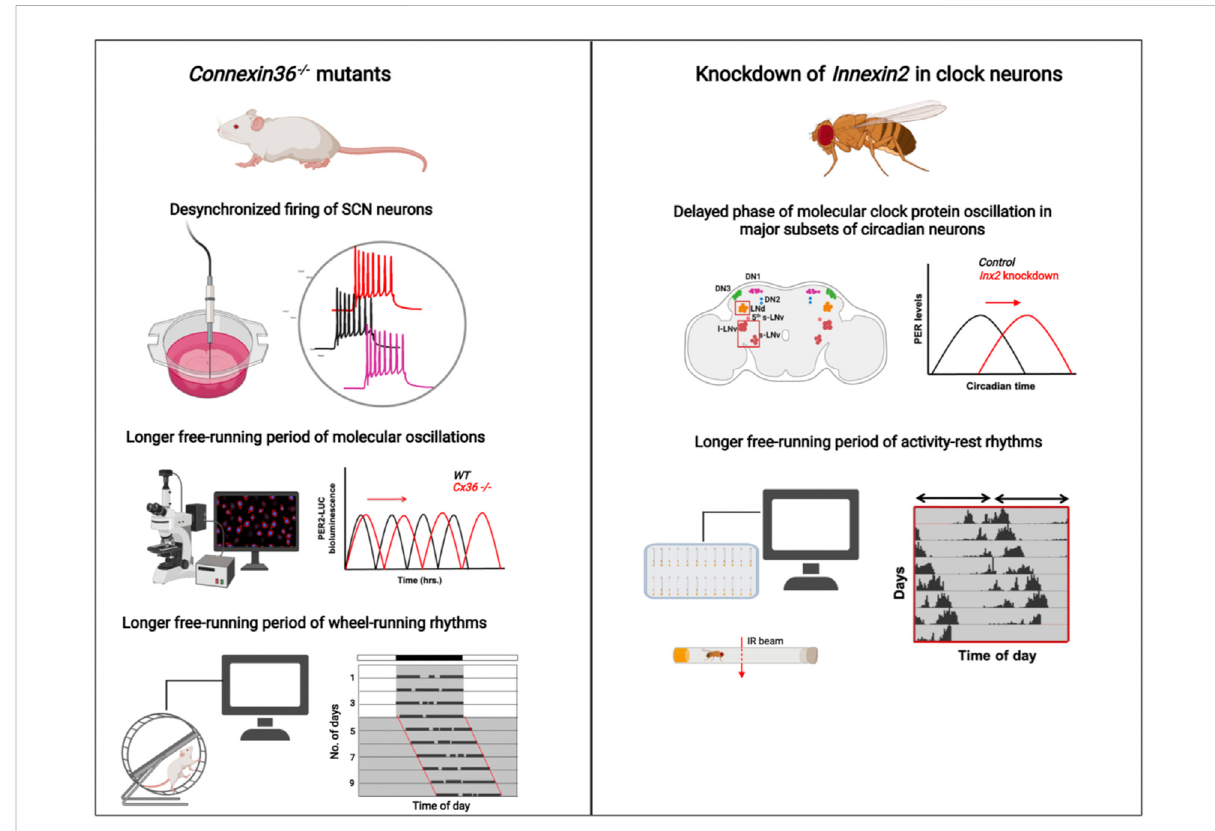
FIGURE 2 Summary of the circadian phenotypes observed in Connexin36 mutant mice (left) and Innexin2 mutant Drosophila (right): (left) Electrophysiological recordings from SCN slices of Cx36 − / − mice show desynchronized fi ring of SCN neurons (Long et al., 2005) , PER2-Luc rhythms in Cx36 − / − mice (red traces) oscillate with a longer free-running period compared to WT mice (black traces) over days (Diemer et al., 2017), and the wheel-running activity of adult mice with Connexin36 mutation runs with a longer free-running period compared to WT mice under constant darkness (Long et al., 2005; Diemer et al., 2017) (right). Knockdown of Innexin2 in clock neurons delays the phase of PER protein oscillation in major clock neuronal subsets in the Drosophila brain and lengthens the free-running period of activity-rest rhythms (Ramakrishnan and Sheeba, 2021). Image created using